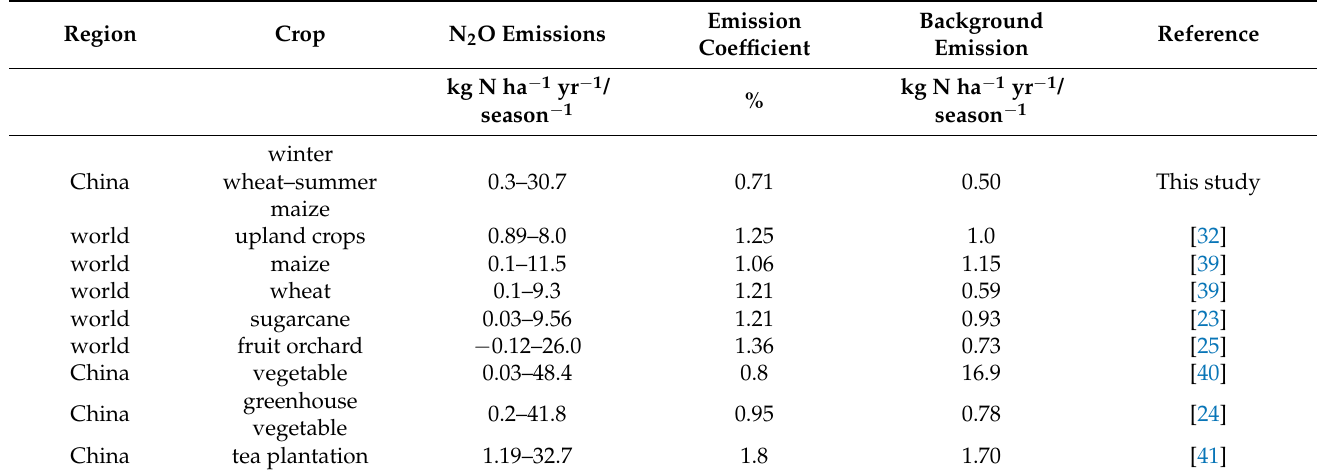
Table 2. Comparison of the observed N 2 O emissions (kg N ha − 1 yr − 1 /season − 1 ) from the fertilized treatments and the estimated emission coefficient (%) and background